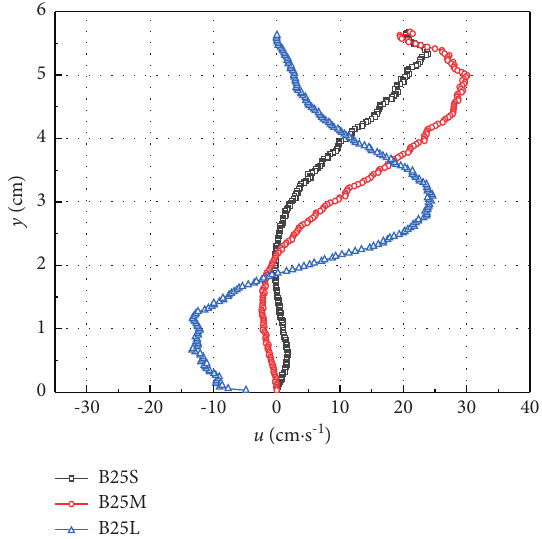
Figure 4: The vertical distribution of the time-averaged longitu- dinal velocity in different working conditions ( x � 2cm).